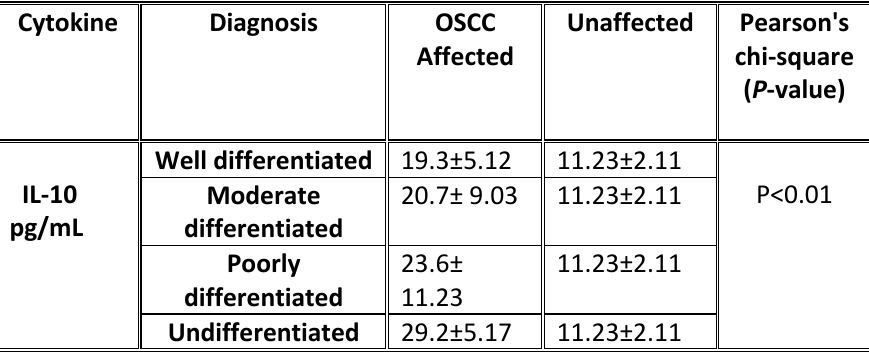
Table 1: Immunological detection of IL-10 in OSCC